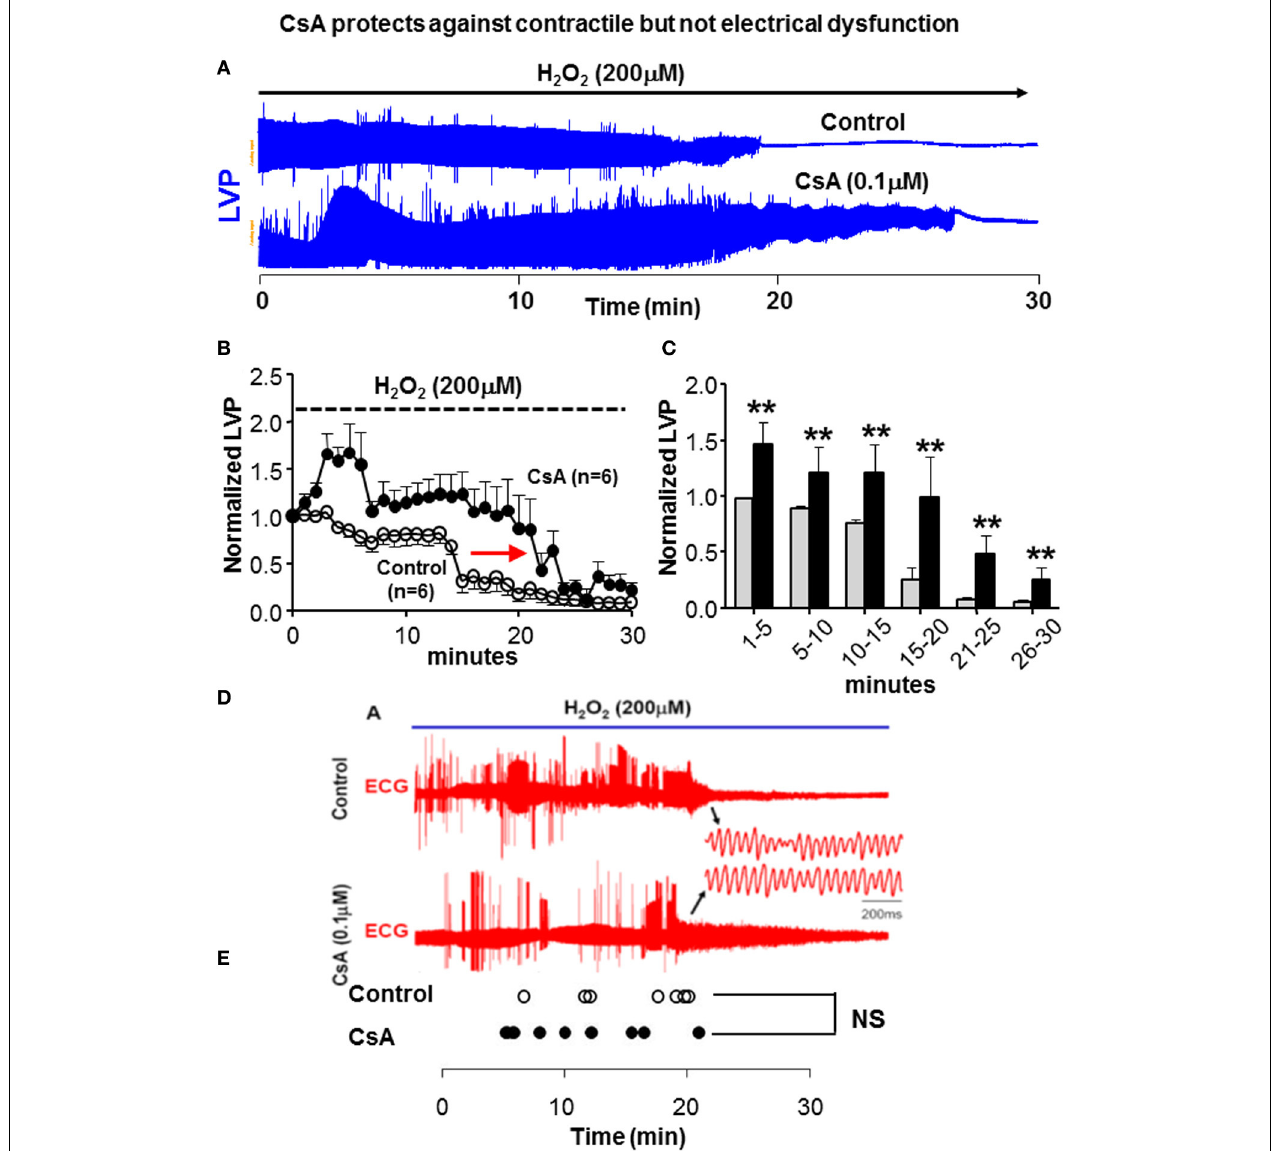
FIGURE 2 | CsA does not protect against electrical dysfunction. (A) Representative time-series of LV pressure waveforms during 30min of H 2 O 2 challenge, indicating reduction and ultimate loss of contractile function. Loss of LVP is delayed in CsA treated hearts. (B,C) Average LVP normalized to the baseline pre-H 2 O 2 value in all control and CsA hearts. Experiments summarized in (A–C) where performed under BDM-free